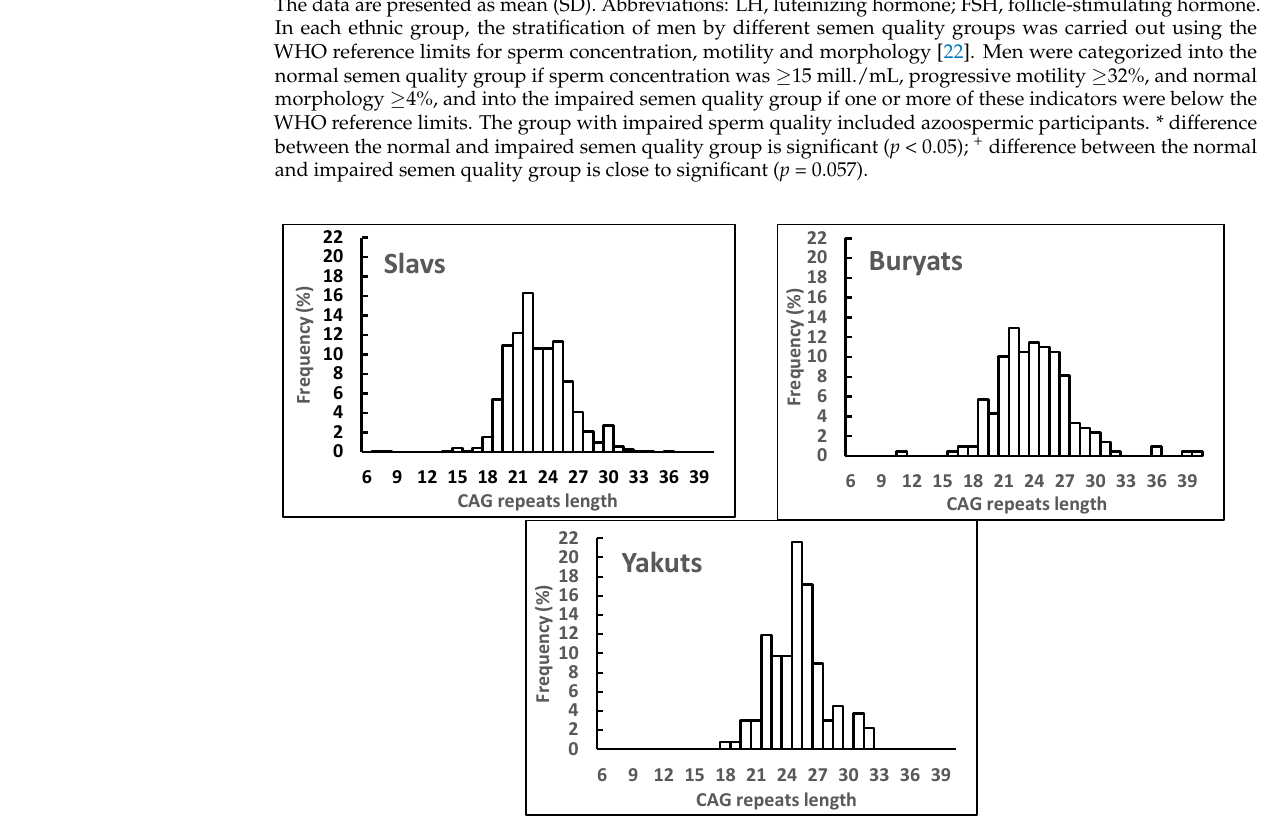
Table 3. CAG repeat length in male subgroups of different ethnicity.